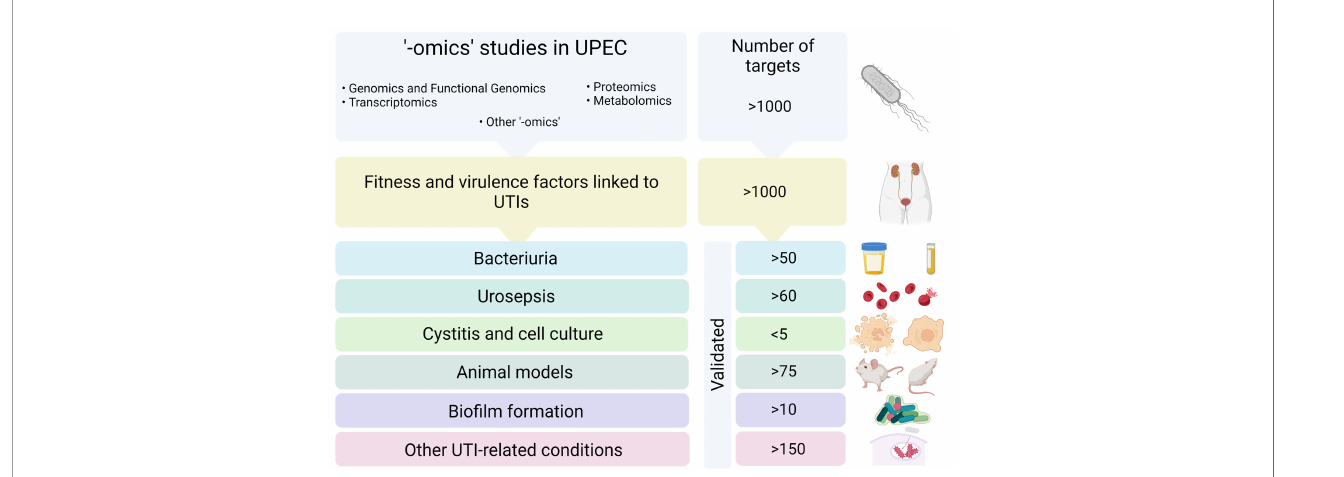
FIGURE 1 | Scheme of the work fl ow followed in this review. Selected articles based on ‘ -omics ’ technologies applied to UPEC were were scrutinized in order to identify fi tness and virulence factors involved in UTIs. The identi fi ed factors were classi fi ed according to the stage of a UTI where they were involved in and validated targets were cross-referenced and tabulated. Created with